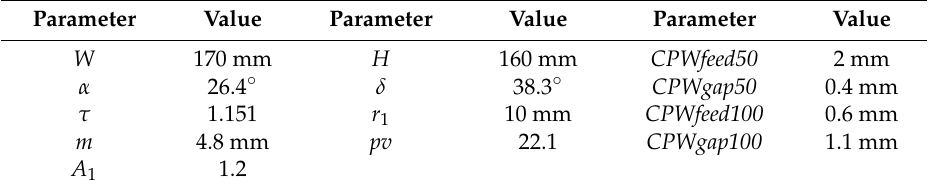
Table 1. The resulting parameters of the manufactured antenna with coplanar waveguide (CPW) feeding.